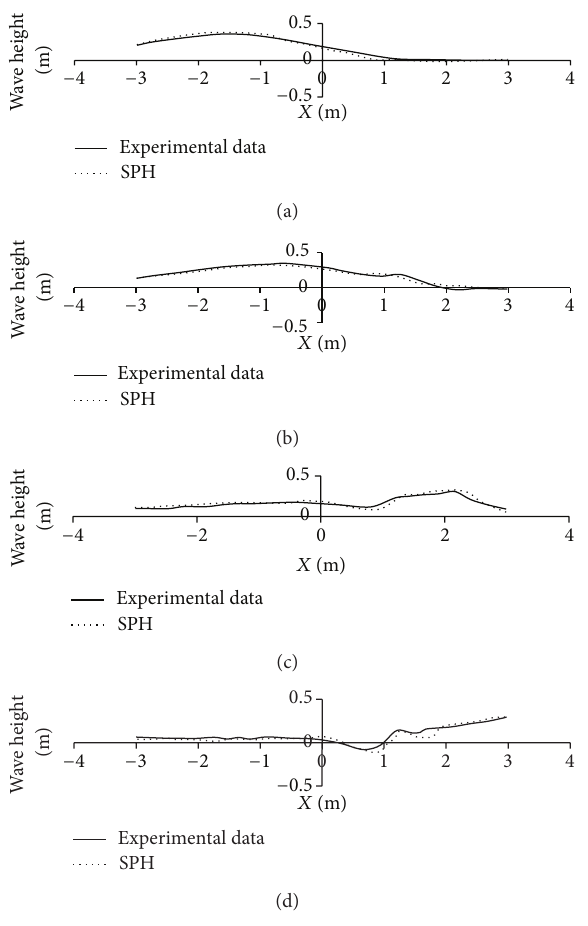
Figure 4: Comparison of SPH’s free surface profile with experimen- tal data [33].